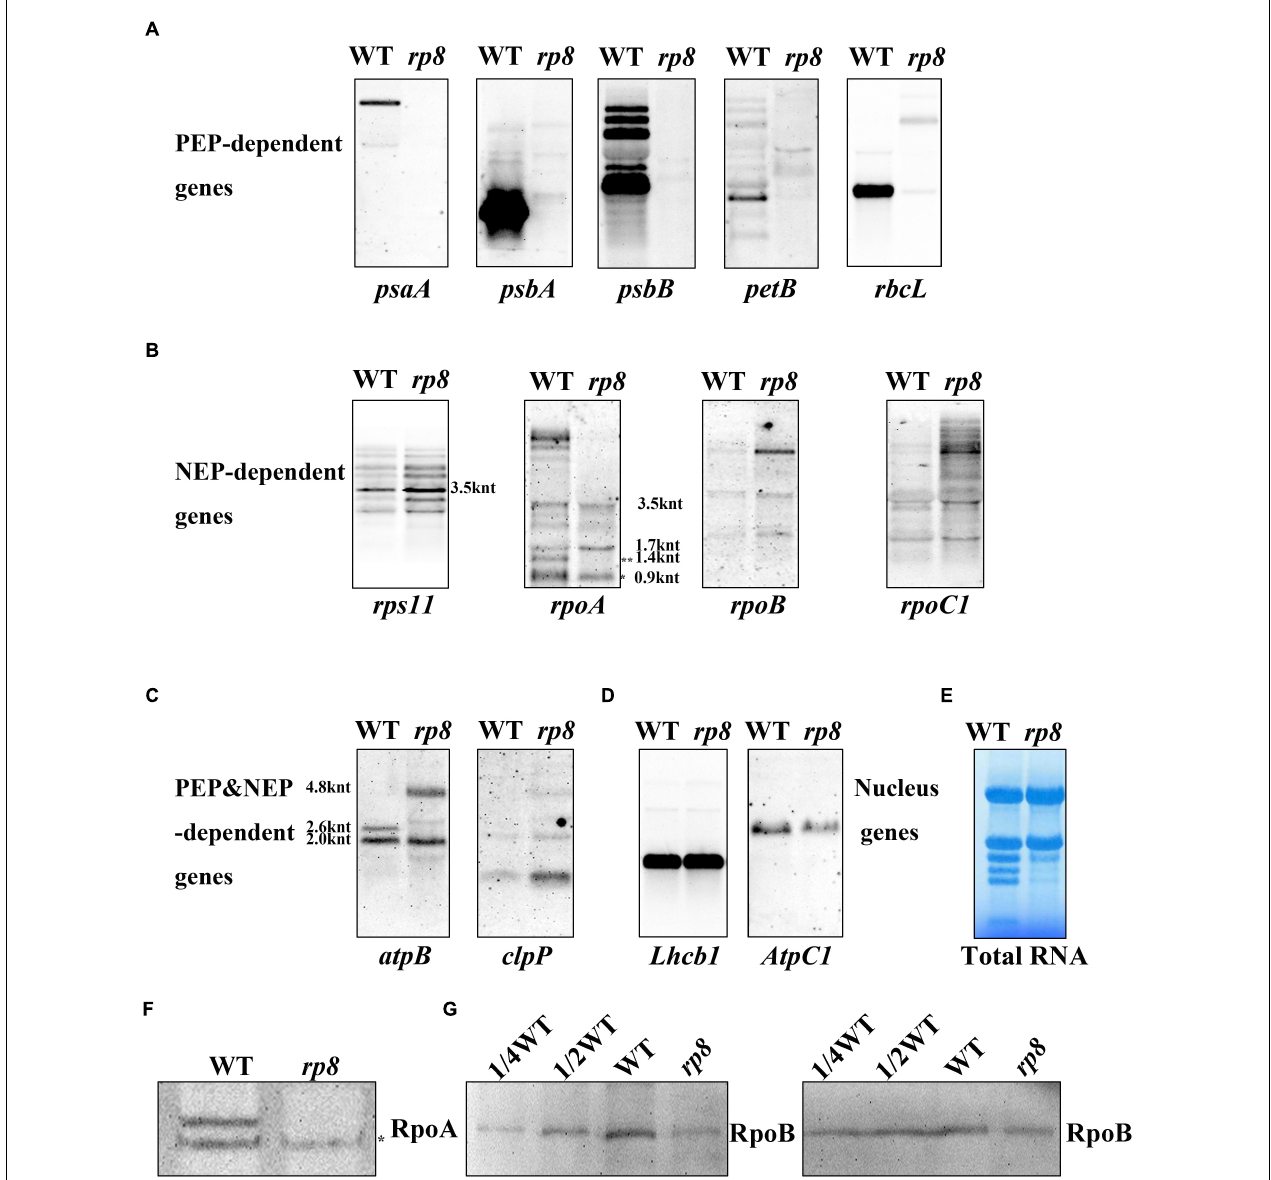
FIGURE 6 | Northern blot analysis of chloroplast-associated genes in the wild type (WT) and the rp8 mutant. (A) Steady-state levels of PEP-dependent transcripts, psaA , psbA , psbB , petB , and rbcL . (B) Steady-state levels of NEP-dependent transcripts ( rps11 , rpoA , rpoB , and rpoC1 ). * Indicates the mature transcripts of rpoA (990 nt), ** indicates the 1.4 knt transcript as described in Zhang et al. (2015). The sizes of the transcripts were indicated according to Wu and Zhang (2010). (C) Steady-state levels of chloroplast transcripts that are both PEP- and NEP-dependent ( atpB and clpP ). As for the atpB transcripts, 4.8, 2.6, and 2.0 knt transcripts are indicated. (D) Steady-state levels of two nucleus genes ( Lhcb1 and AtpC1 ). (E) Methylene blue staining of total RNA for loading control. About 10 µ g total RNA was transferred to a nylon membrane after electrophoresis, then probed with DIG-labeled probes. (F) Immunoblot analysis of RpoA with the antibody described in Zhang et al. (2018) (*represents the specific band for the RpoA protein). (G) Immunoblot analysis of RpoB protein levels in the wild type (WT) and the rp8 mutant. Total proteins from the WT samples were loaded with three different concentrations (7.5, 15, and 30 µ g), and total proteins from the mutant samples were loaded with 30 µ g, respectively. Arabidopsis mutant ptac10 with a decreased RpoB protein level was used as a control (Chang et al., 2017; Yu et al., 2018).